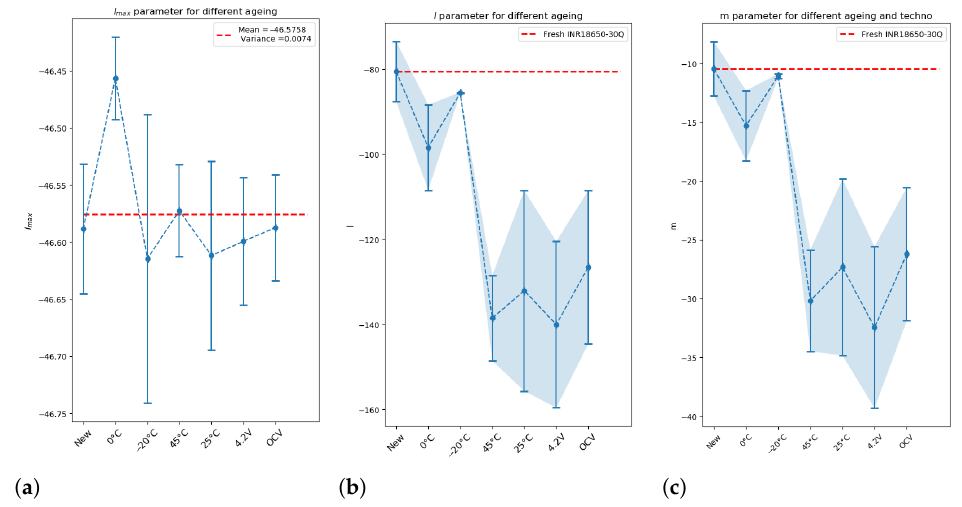
Figure 8. Kinetic parameters. ( a ) l max parameter for different ageing conditions. ( b ) l parameter for different ageing conditions. ( c ) m parameter for different ageing